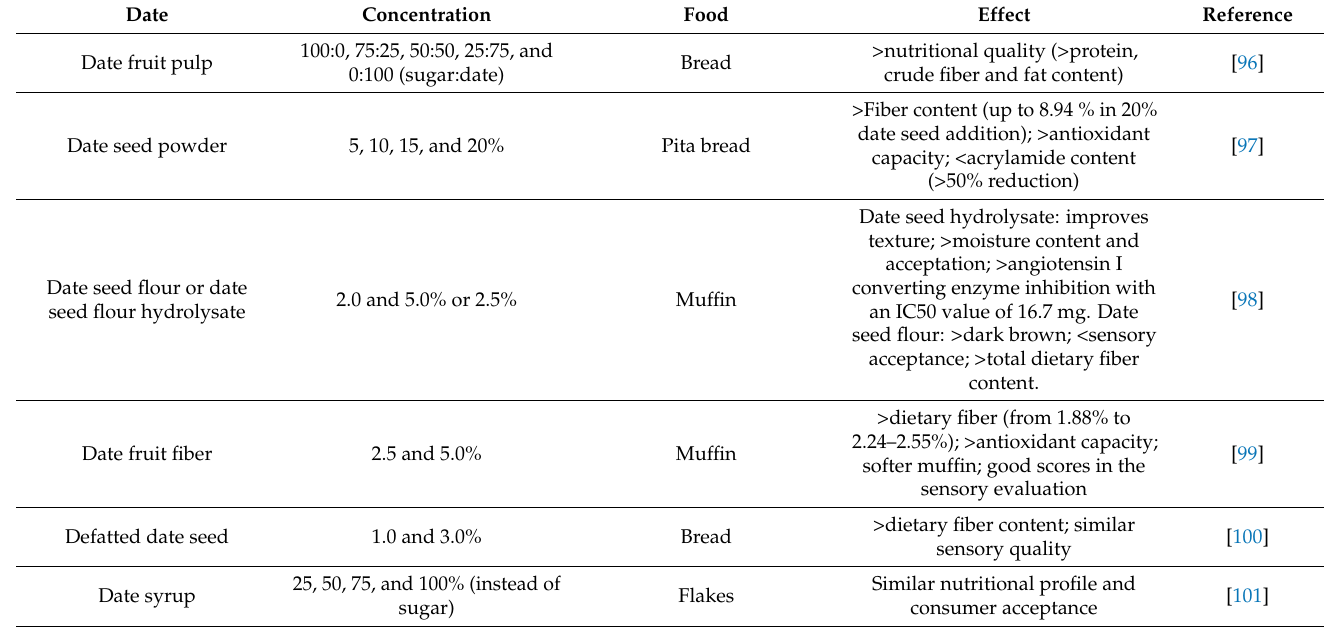
Table 3. Summary of different studies about the application of date fruit and its co-products in bakery